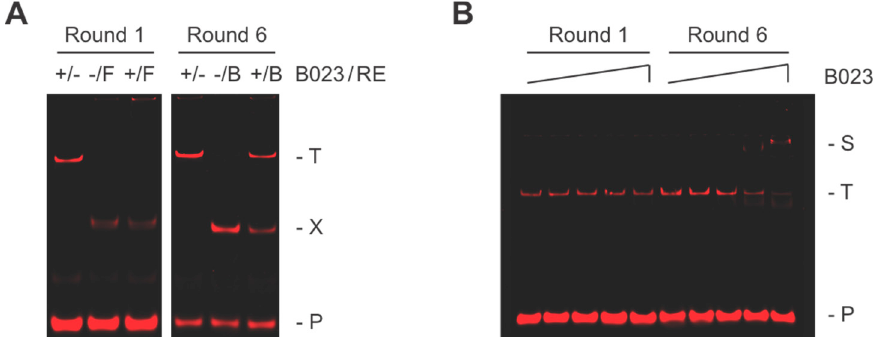
Figure 1. Selection and validation of TTHB023-binding DNA sequences. ( A ) Shown are IR fluorescence images of cleavage protection assays from Round 1 and Round 6 of Restriction Endonuclease Protection, Selection and Amplification (REPSA) selection with 17 nM TTHB023 protein. The presence ( + ) or absence ( − ) of TTHB023 and IISREs FokI (F) or BpmI (B) is indicated above each lane. Locations of intact (T) and cleaved (X) ST2R14 selection template and the IRD7_ST2R primer (P) are indicated at right of figure. ( B ) Shown are IR fluorescence images of Electrophoretic Mobility Shift Assays (EMSAs) made with DNA from REPSA Round 1 (left lanes) and Round 6 (right lanes) incubated with increasing TTHB023 concentrations (from left to right: 0, 0.83, 8.3, 83, or 830 nM TTHB023). Electrophoretic mobility of a single TTHB023–DNA complex (S) as well as the uncomplexed template (T) and primer (P) are indicated at figure right.